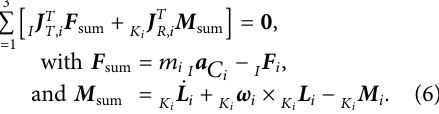
Frontiers in Robotics and AI |